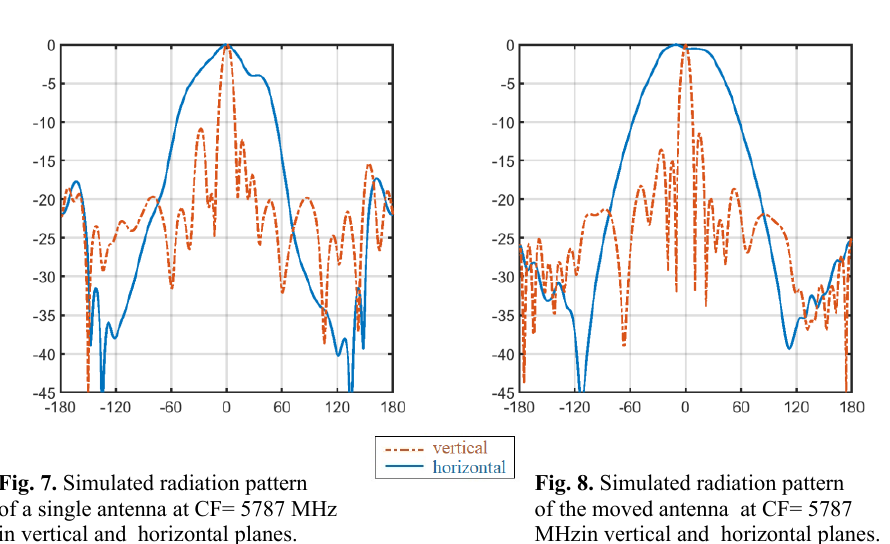
Fig. 8. Simulated radiation pattern of the moved antenna at CF= 5787 MHzin vertical and horizontal